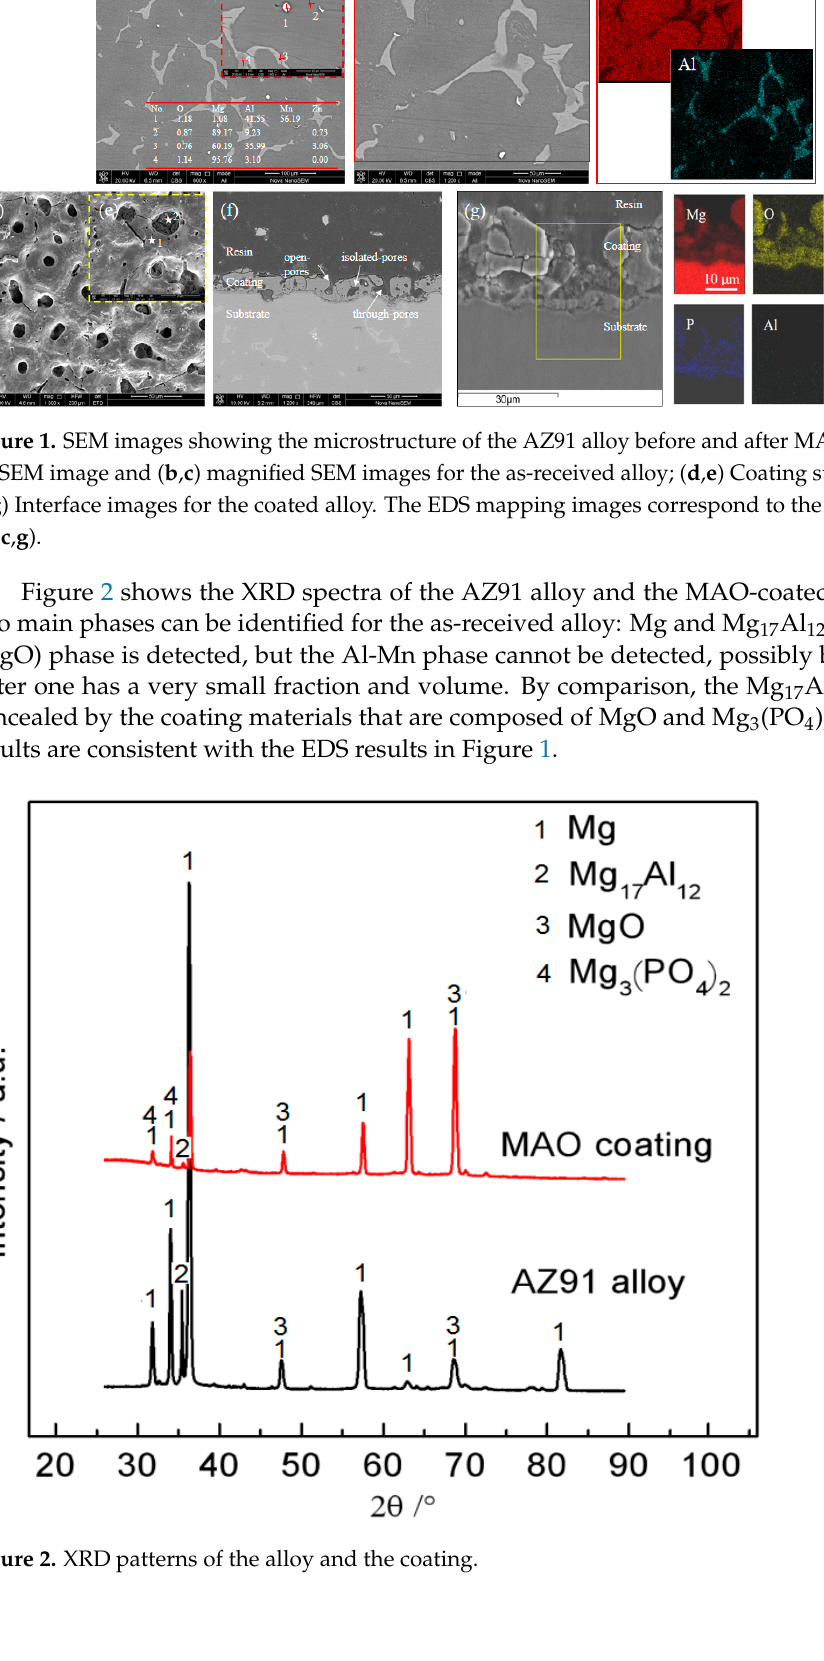
Figure 2. XRD patterns of the alloy and the coating.